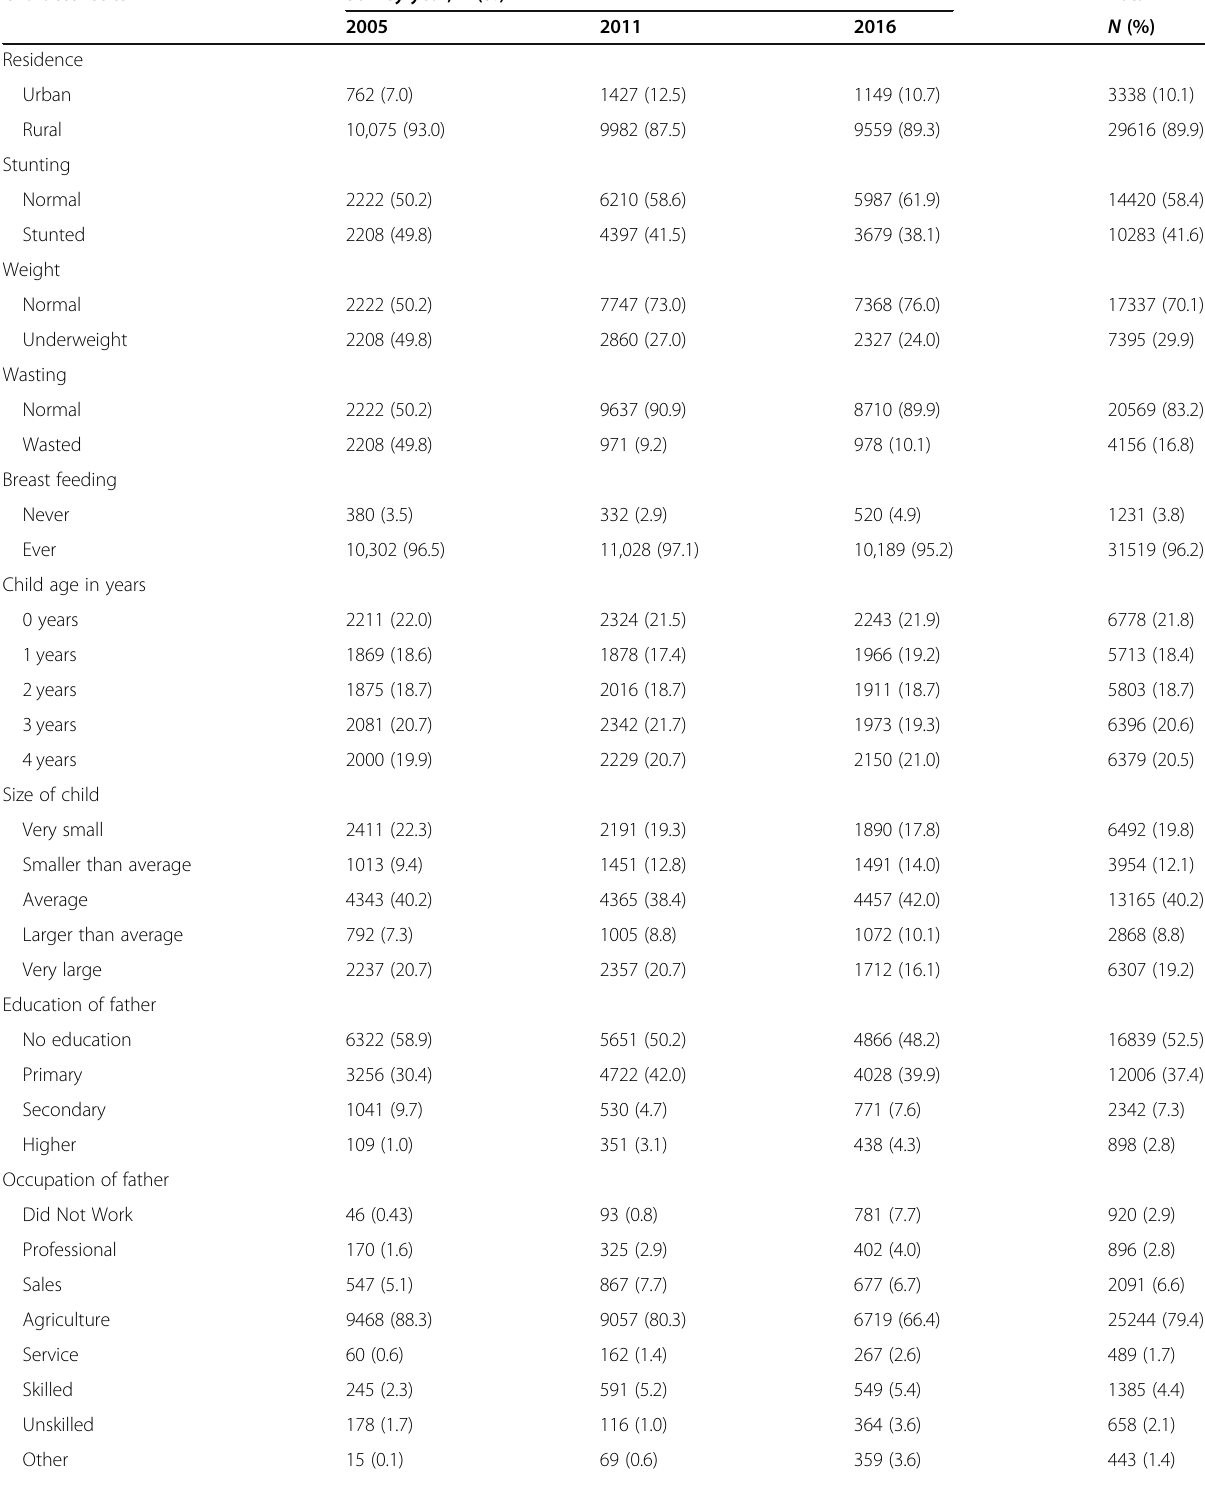
Table 1 Socio-demographics of households and under-five children characteristics, EDHS 2005 – 2016